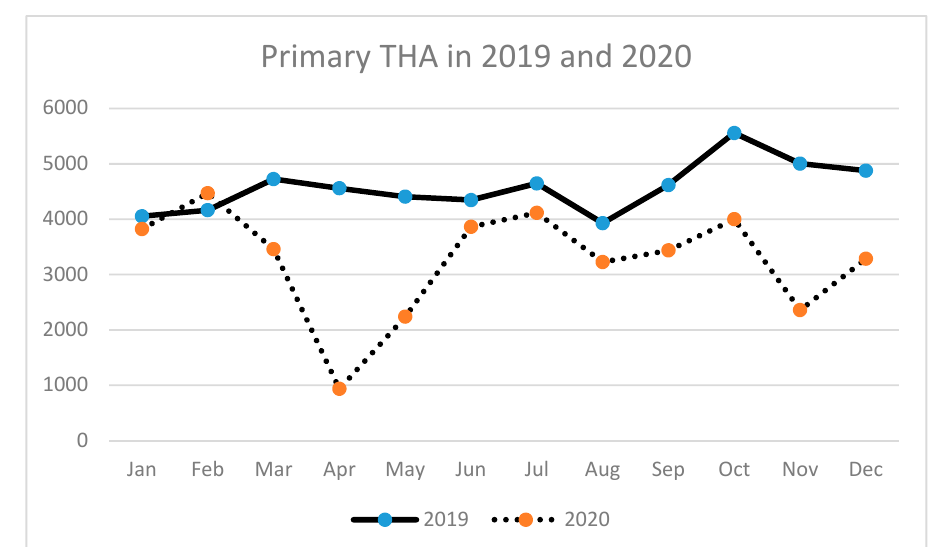
Figure 2. Number of total hip arthroplasties (THA) performed in the particular months of 2019 and 2020 in Poland.